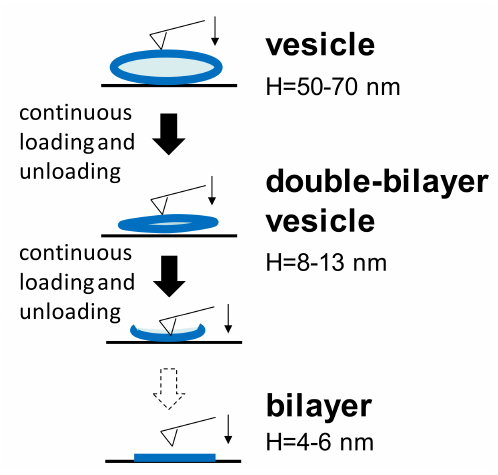
Figure 2. Three different structures appearing in continuous loading and unloading at two